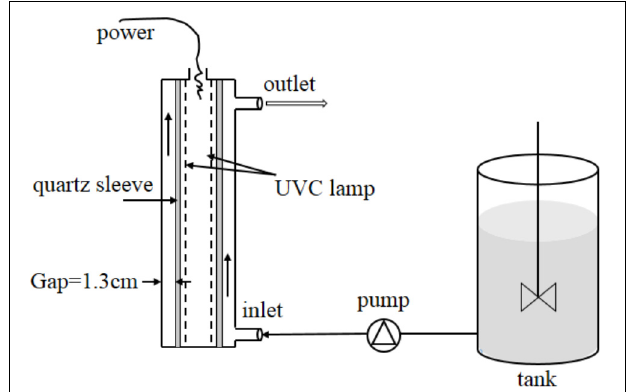
FIGURE 1 | Schematic diagram of continuous-flow UVC disinfection unit. One low-pressure mercury arc lamp (254 nm, 14 W) mounted in a quartz sleeve running through the center of a chamber. The unit and lamp was covered by a stainless steel cylinder. The bacterial culture was pumped from the tank through a 1.3-cm annular gap between the inner surface of the chamber and the outer surface of the quartz sleeve.